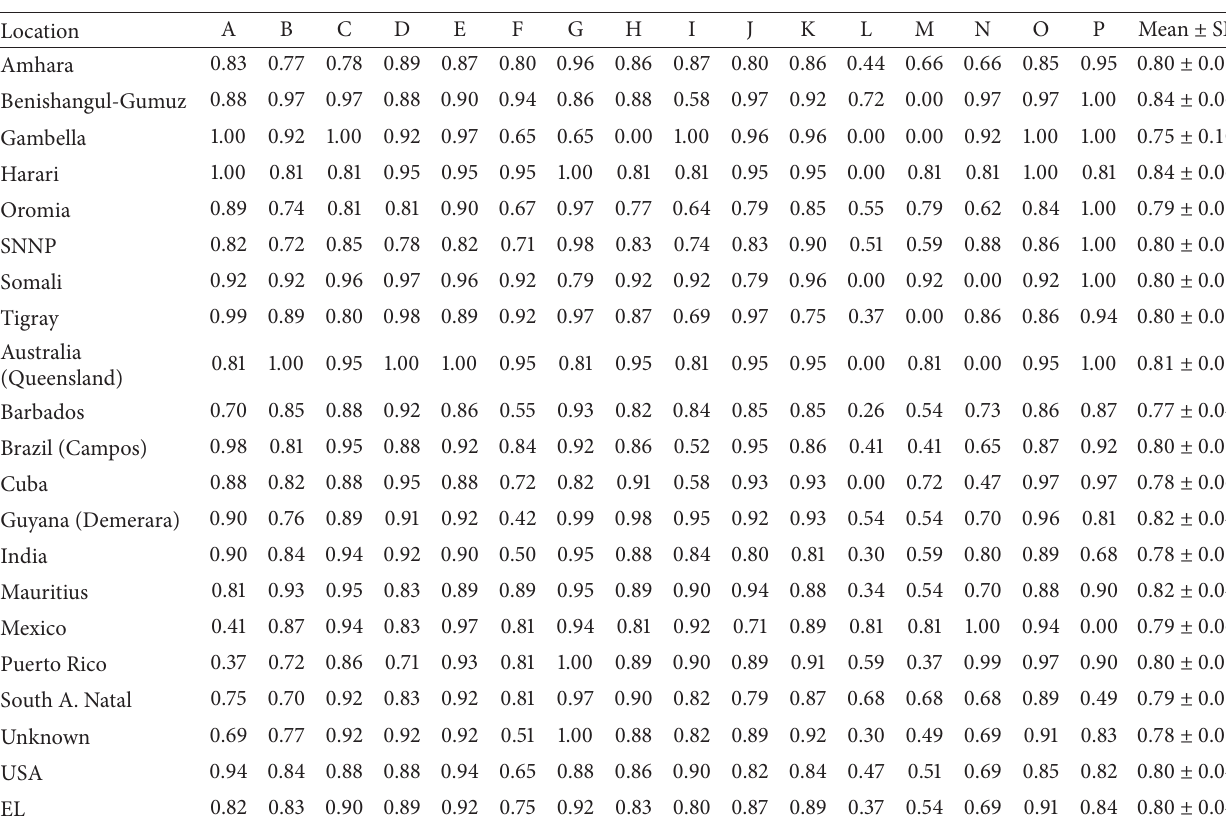
Table 3: Estimates of the Shannon-Weaver diversity index ( 𝐻 󸀠 ), for 16 qualitative characters in 400 sugarcane genotypes by location of collection of local and country of introduction of exotic